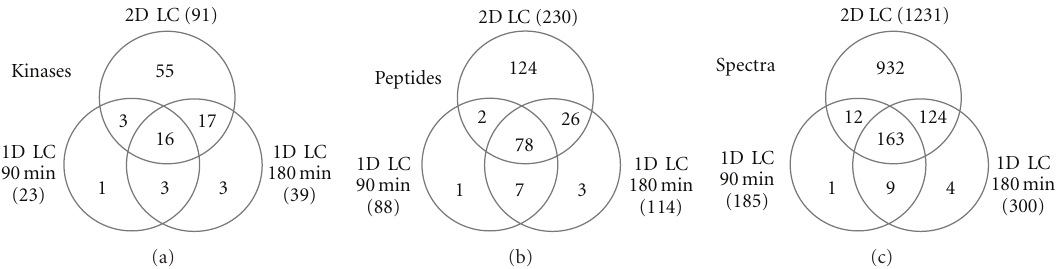
Figure 2: Venn-diagrams of kinases (with ≥ 2 peptides) (a), peptides (b), spectra (c) derived from each two technical replicates: 1D LC-MS (90 and 180 min gradient and 2D LC-MS).